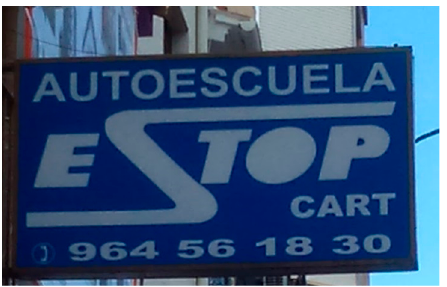
Figure 42. Almazora: Language contact on a driving school sign .